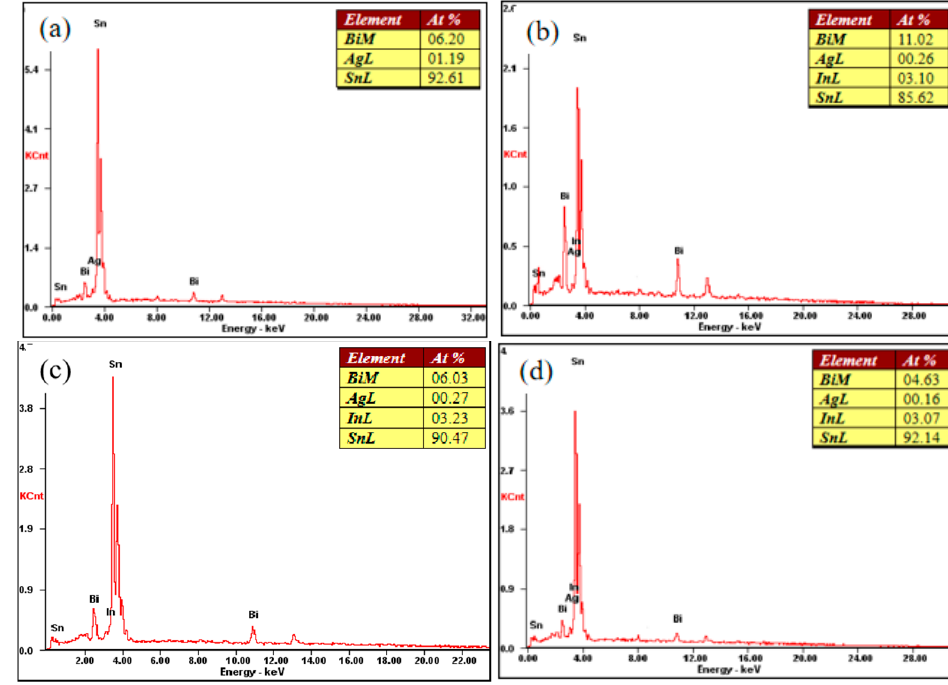
Figure 7. Energy spectrum analysis of points A ( a ), B ( b ), C ( c ) and D ( d